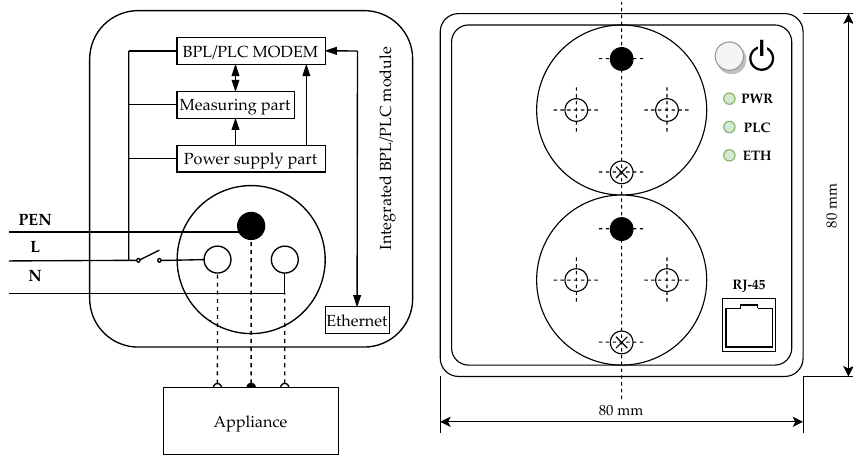
Figure 5. ( left ) Block diagram; and ( right ) Front panel of integrated BPL